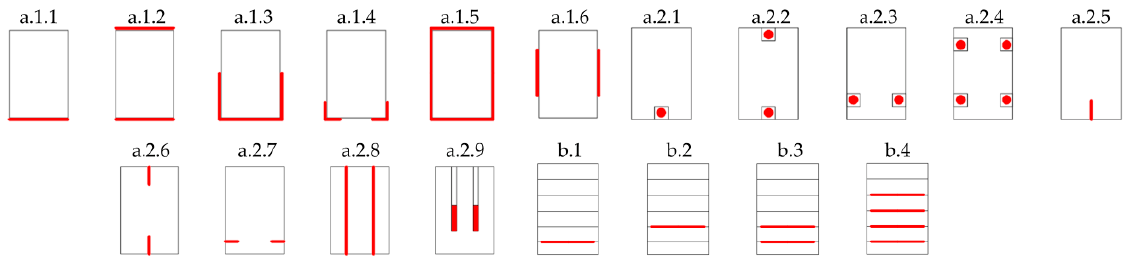
Figure 1. Strengthening layouts of timber beams [7].